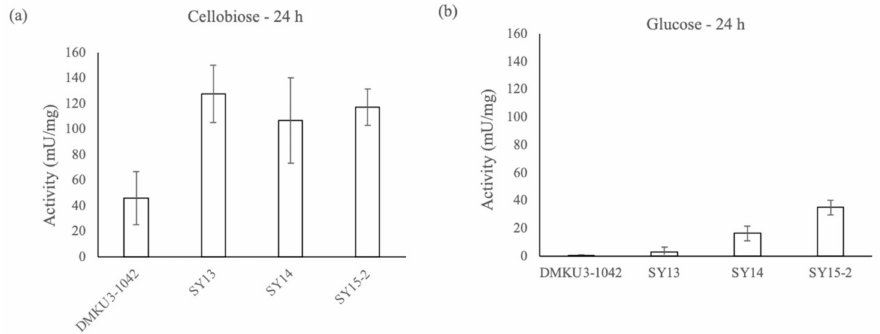
Figure 2. Measurement of ß -glucosidase activity. Cells were grown in YAYC medium ( a ) or YAYD medium ( b ) for 24 h, and crude extracts were prepared and subjected to enzyme assays as described in Materials and